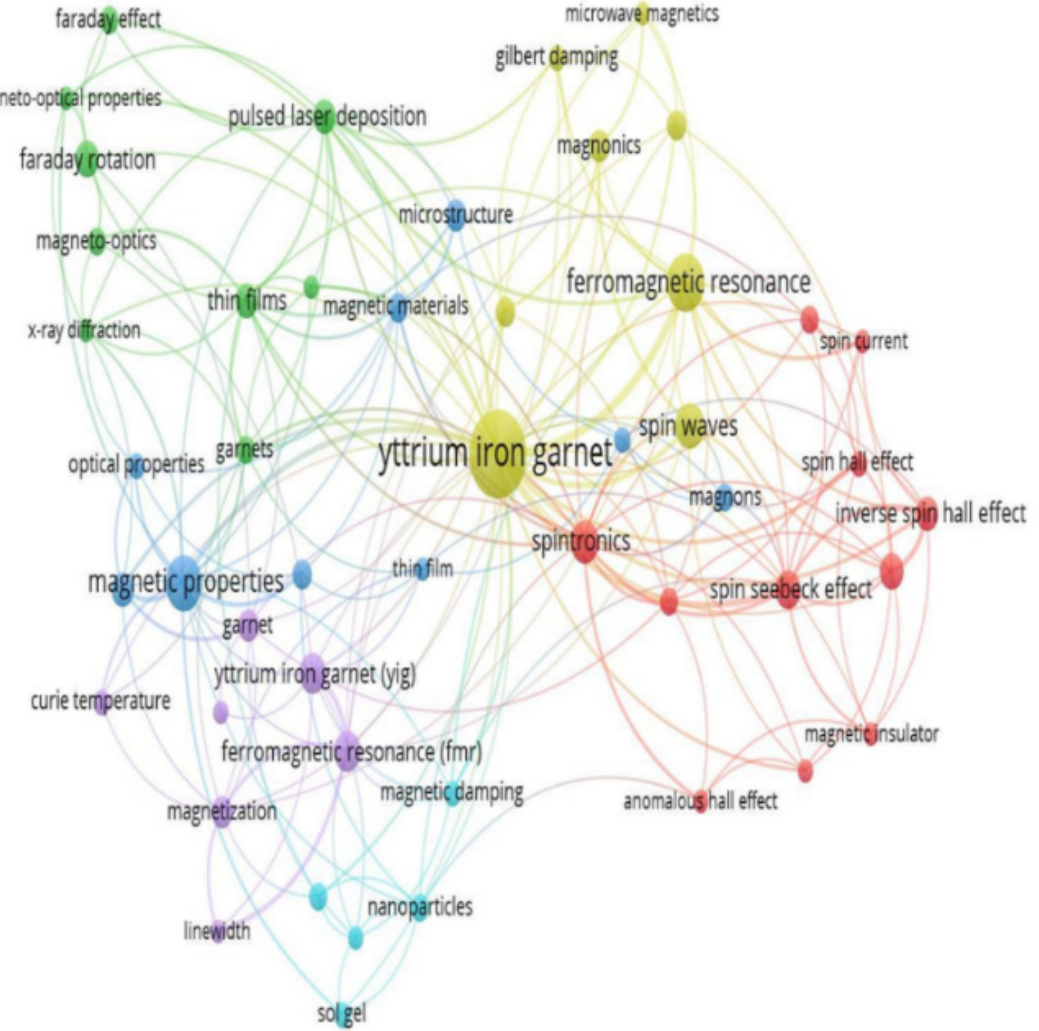
Figure 6. Co-occurrence of author keywords (number of occurrences 112